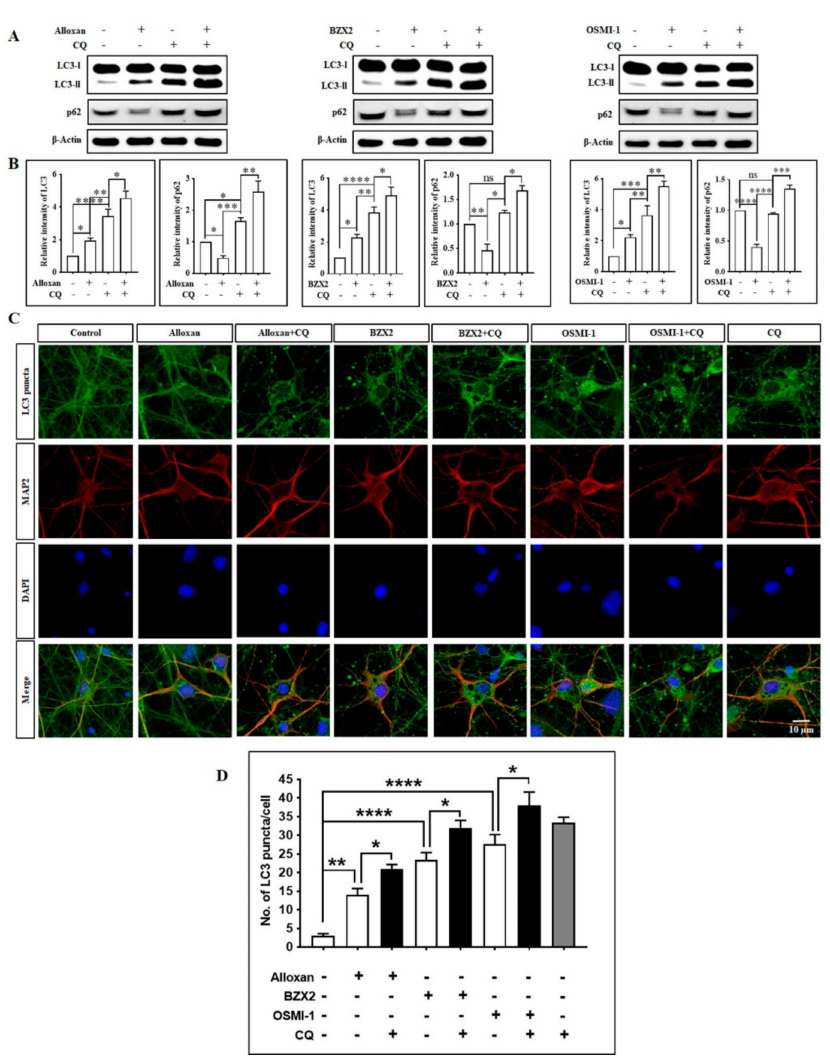
Figure 4. OGT inhibitors stimulate autophagic activities in rat cortical neurons. ( A ) After the treatment with alloxan, BZX2, and OSMI-1, cortical neurons were incubated with chloroquine (10 µ M) for 2 h before harvesting. LC3 and p62 expression levels were determined by immunoblot analysis. ( B ) Data are presented as mean ± SEM ( n = 3, ns; non-significant, * p < 0.05, ** p < 0.01, *** p < 0.001, **** p < 0.0001). ( C ) Cortical neurons were treated with alloxan, BZX2, or OSMI-1 for 24 h, and chloroquine was applied for 2 h before fixation. The neurons were then stained with Alexa fluor 488 conjugated-anti LC3-II antibody (green) and MAP2 (red). Images were acquired with confocal microscopy. ( D ) LC3 puncta formation was measured from at least 3 independent random areas from each slide. A minimum of 5 cells were counted and calculated, which contained puncta (ns = non-significant, * p < 0.05, ** p < 0.01, **** p <